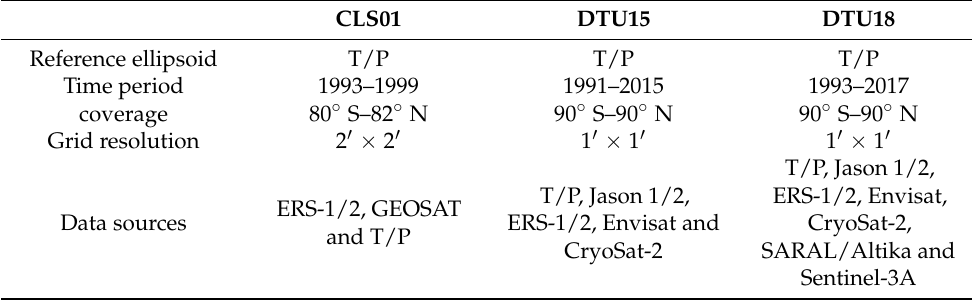
Table 1. A comparison of three widely used mean sea surface (MSS) models.